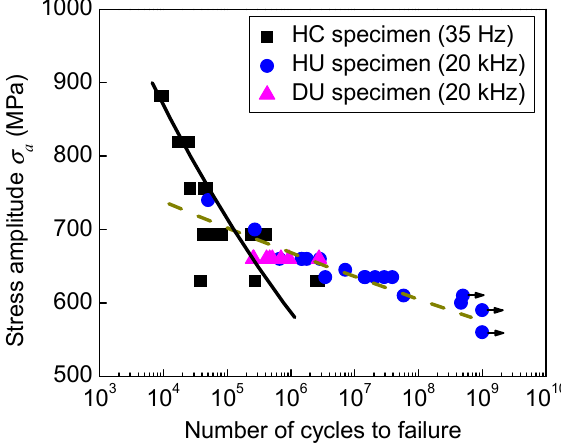
Figure 5. S-N data of specimens with different geometry shapes, in which the arrow denotes the specimen unbroken.